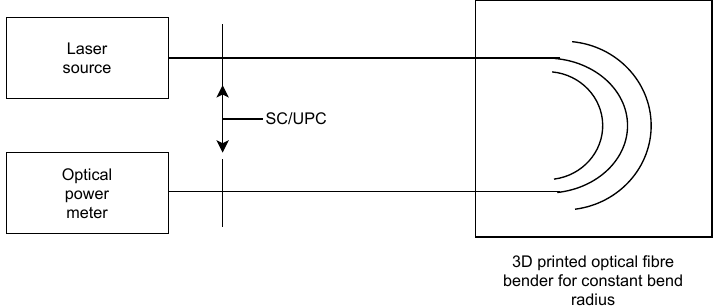
Figure 6. Scheme of attenuation measurement using the reference